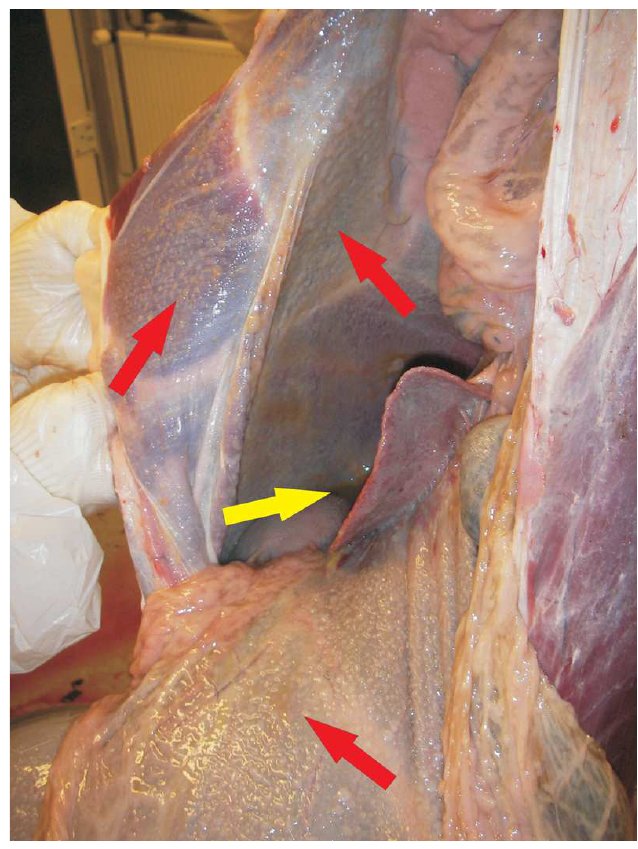
Fig. 2. Fibrin membranes covering the peritoneum and visceral organs (dark arrows) and straw coloured ascites fluid (pale arrow) giving an impression of purulent process.